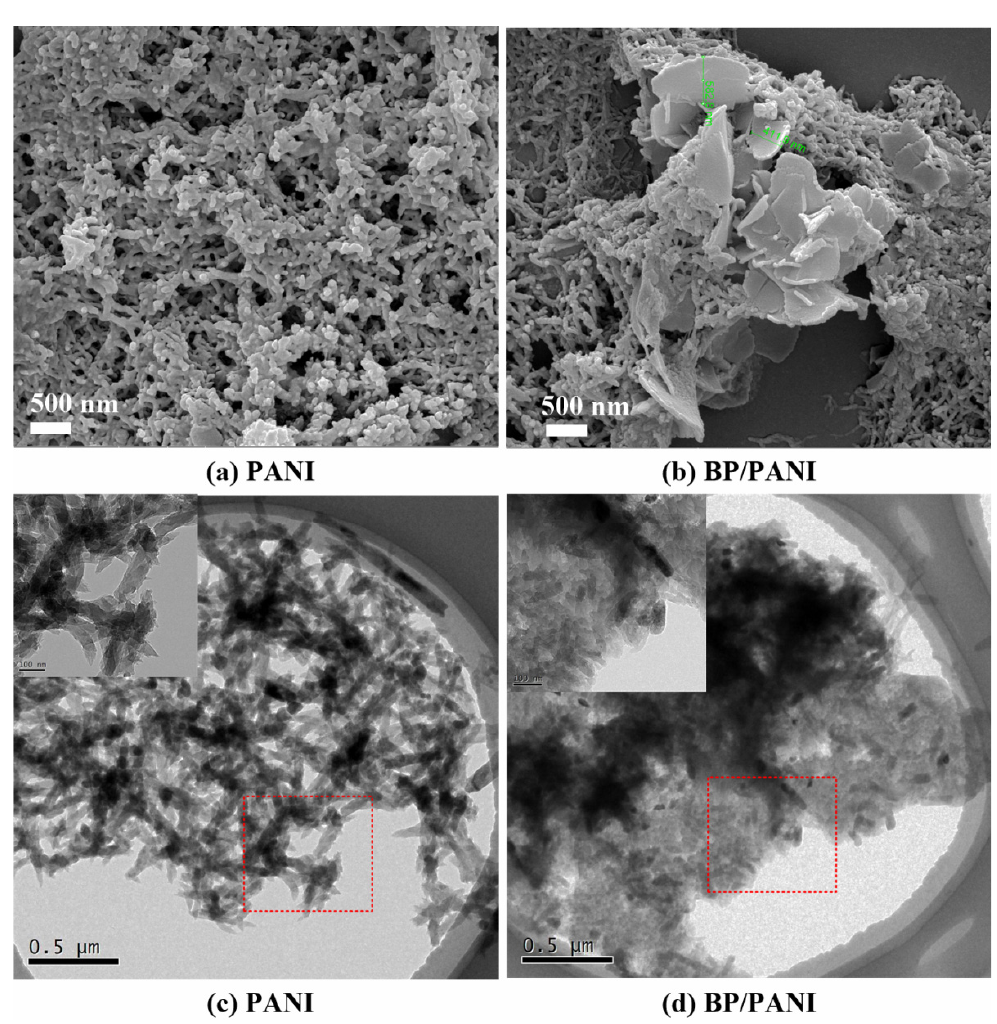
Figure 3. SEM and TEM images of ( a , c ) PANI and ( b , d ) BP/PANI.